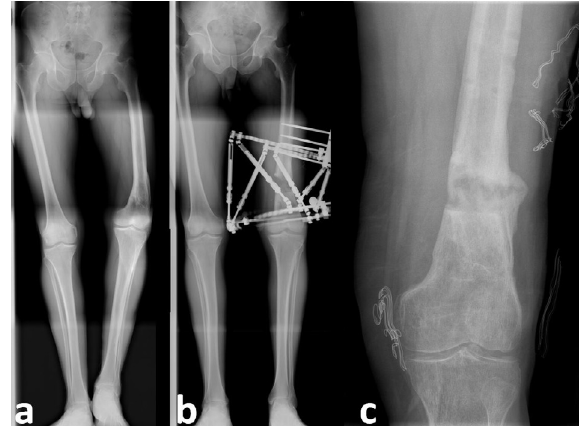
Figure 7. Case No. 6 in Table 1. (a) Varus deformity of femur with preoperative 5-cm shortness, (b) same patient after correction with the Spider Frame, (c) same patient after the removal of Spider